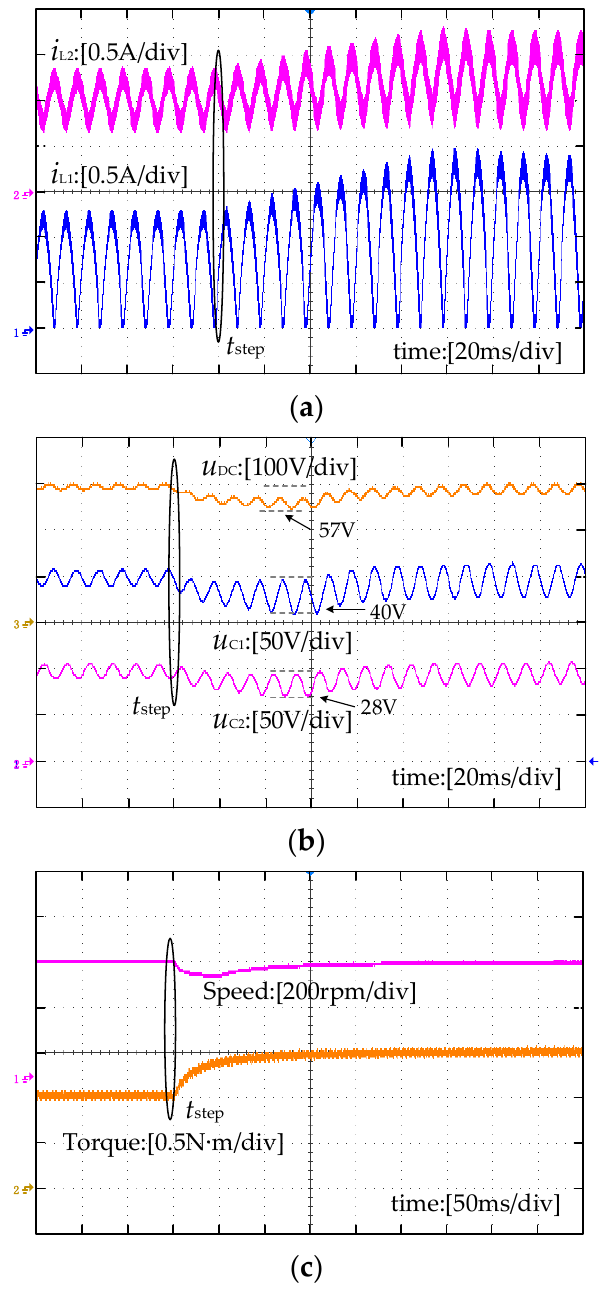
Figure 11. Dynamic experimental waveforms of ECL motor driver under traditional PI control with load-up from 1 to 1.5 Nm. ( a ) The current i L1 and the current of L 2 . ( b ) DC-link voltage u DC , the voltage of C 1, and the voltage of C 2 . ( c ) Motor speed and motor torque.